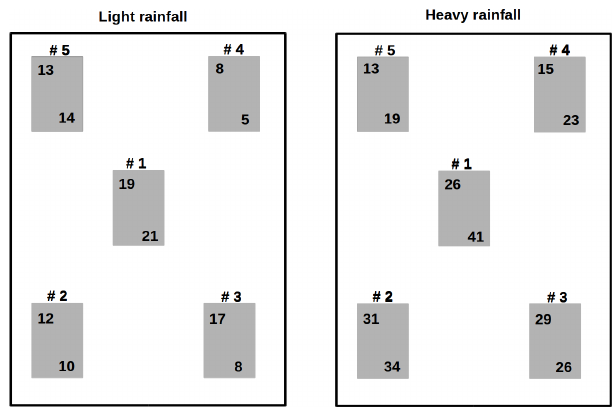
Figure 5. Average rain rate expressed in millimetres per hour for each location (#) for both light and heavy rainfall